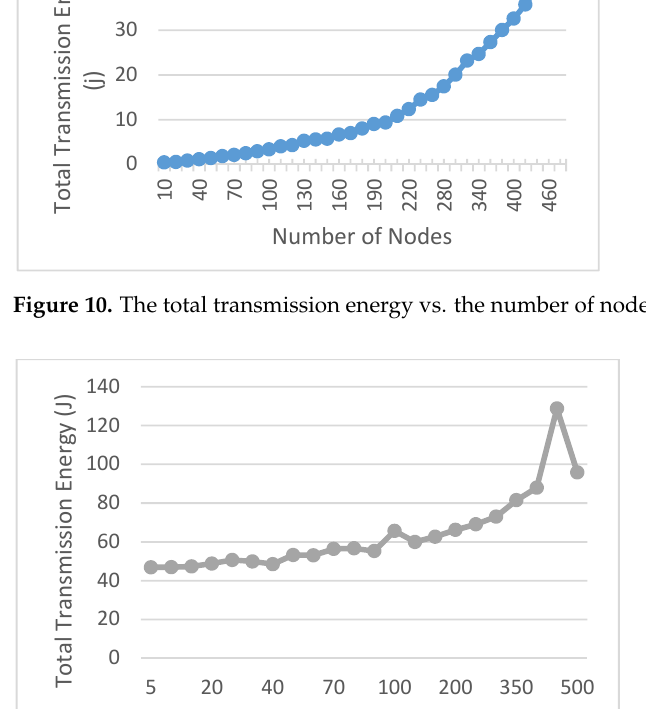
Figure 11. The total transmission energy vs. the number of miner nodes in the PoW model.